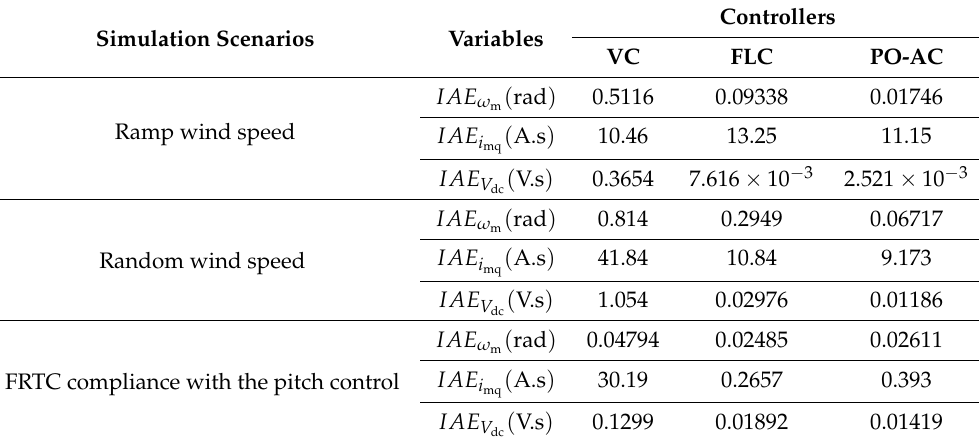
Table 2. IAE indices of different controllers in different